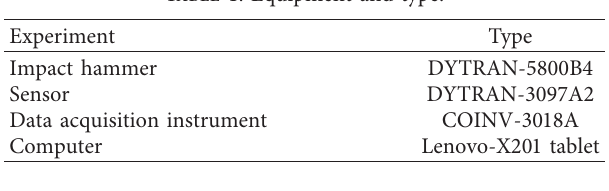
Table 1: Equipment and type.